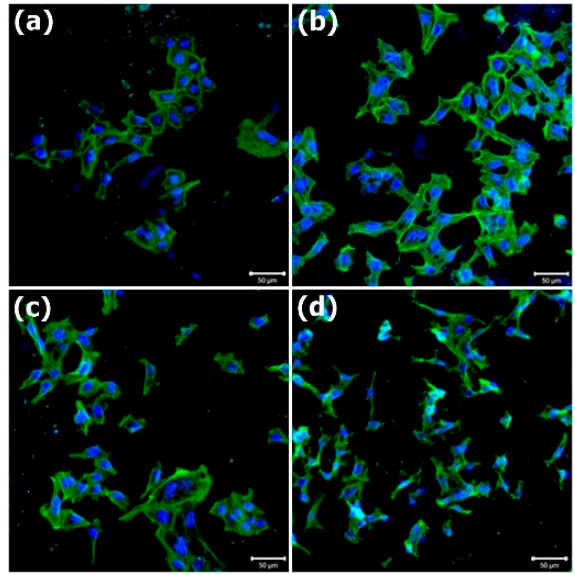
Figure 5. Representative images of MG63 osteoblast-like cells cultured on ( a ) PCL, ( b ) PCL–SrHANF(65), ( c ) PCL–SrHANF (130), and ( d ) PCL–SrHANF(195) after 1 day of culture. Cytoskeletal F-actin is stained green with fluorescein isothiocyanate (FITC), and cell nuclei are stained blue with 4’,6-diamidino-2-phenylindole (DAPI). Scale bar = 50 µm.